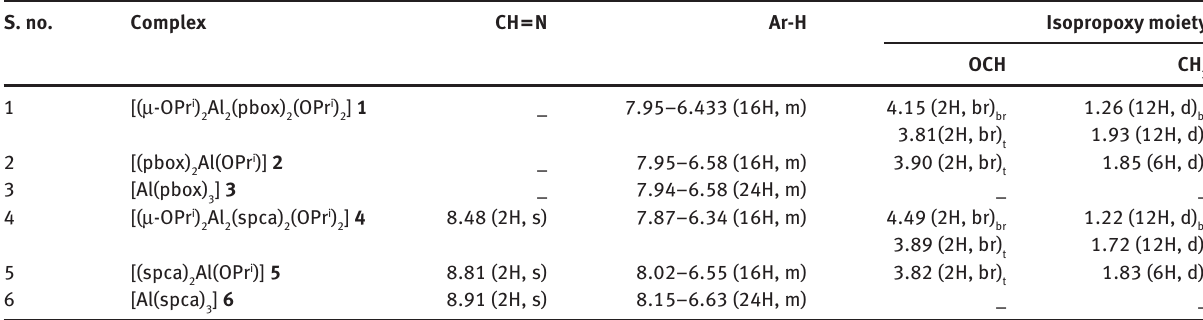
Table 3: 1 H NMR data (ppm) for new complexes of aluminium (IV) 1–6 . S.